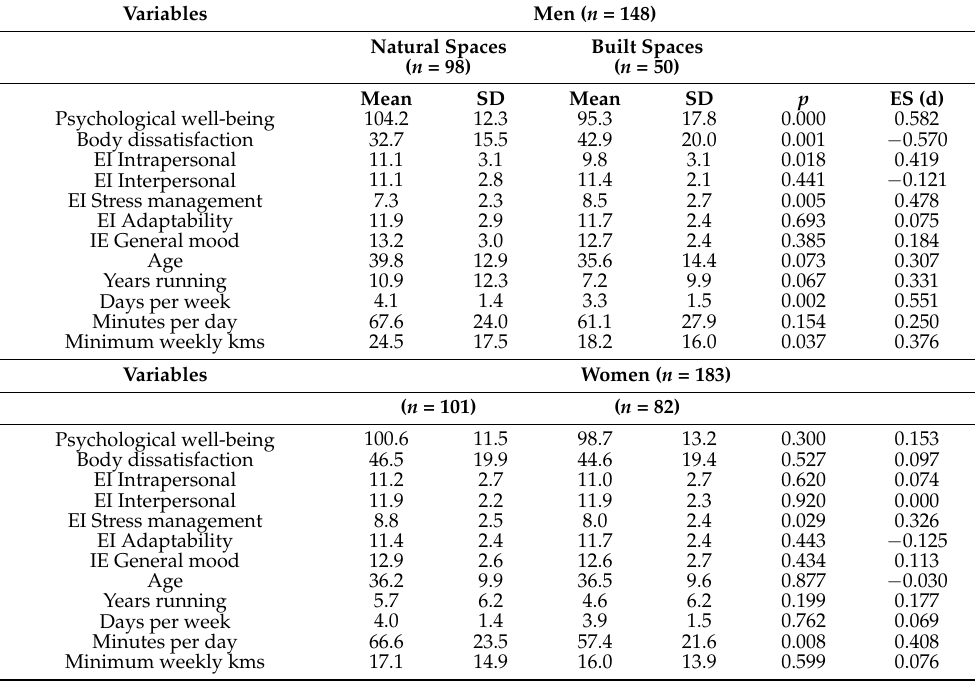
Table 2. Comparison of well-being, satisfaction, emotional intelligence, and sports practice by sex, according to running